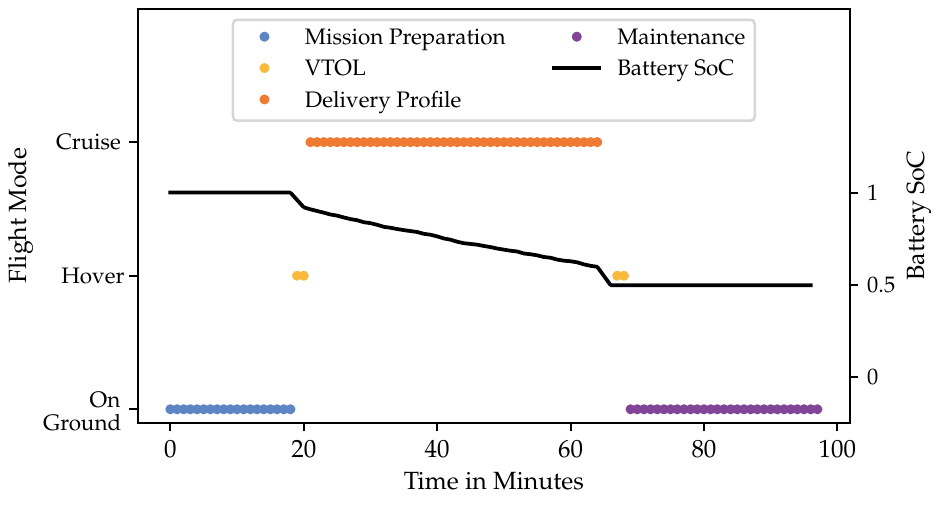
Figure 3. Delivery mission profile with different mission phases and energy consumption.